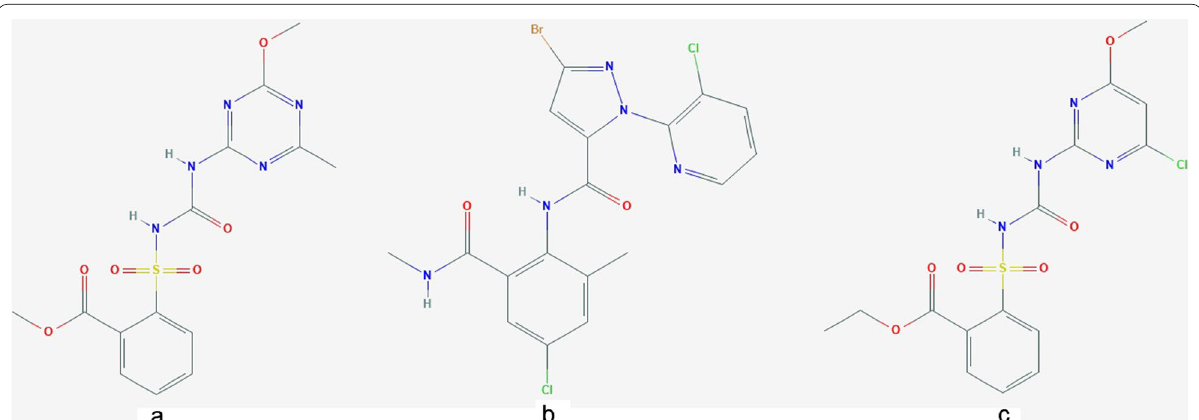
Fig. 1 Chemical structures of a metsulfuron-methyl, b chlorantraniliprole and c